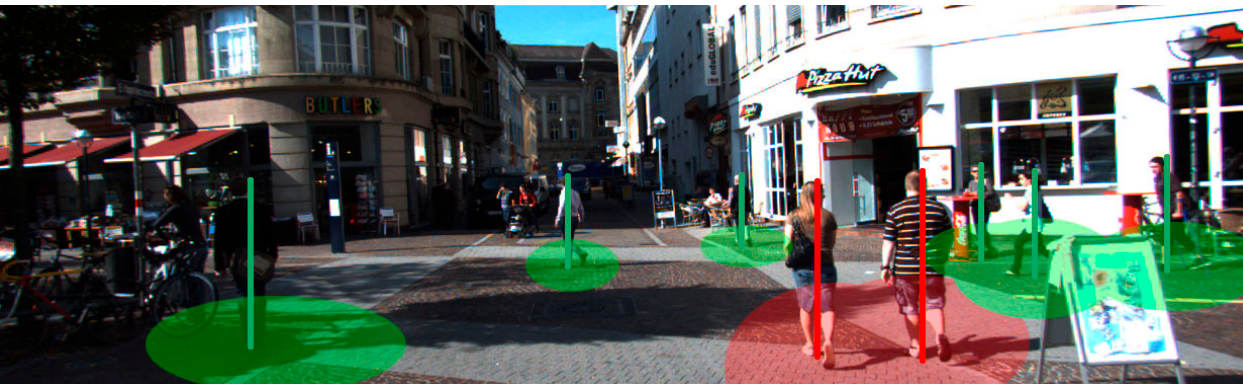
Figure 9. An example scene showing acceptable social distancing.